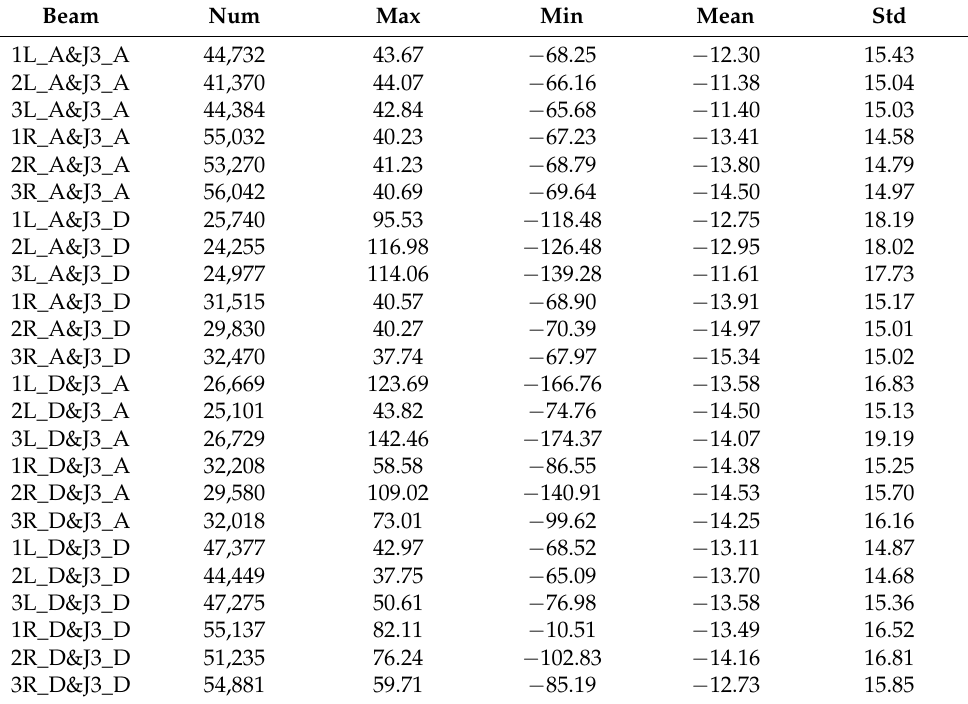
Table 6. Differences in SSHs at the cross-crossover points of ICESat-2 strong beam and Jason-3 (“A” represents the ascending orbit, “D” represents the descending orbit, “J3” represents Jason-3, and L/R and 1/2/3 represent the corresponding ICESat-2 beam) (Unit: cm).